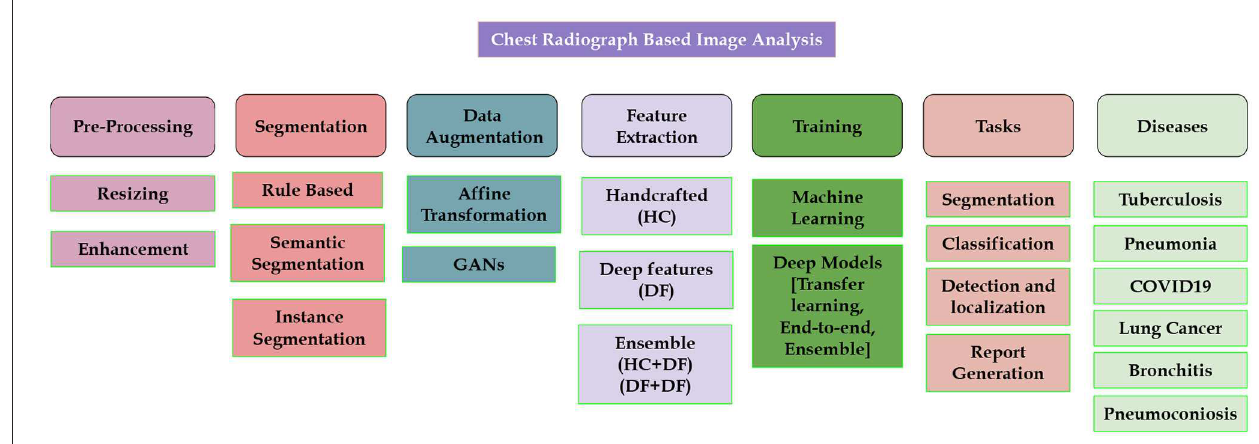
FIGURE3 Showcasing research problems which have been studied in the literature.